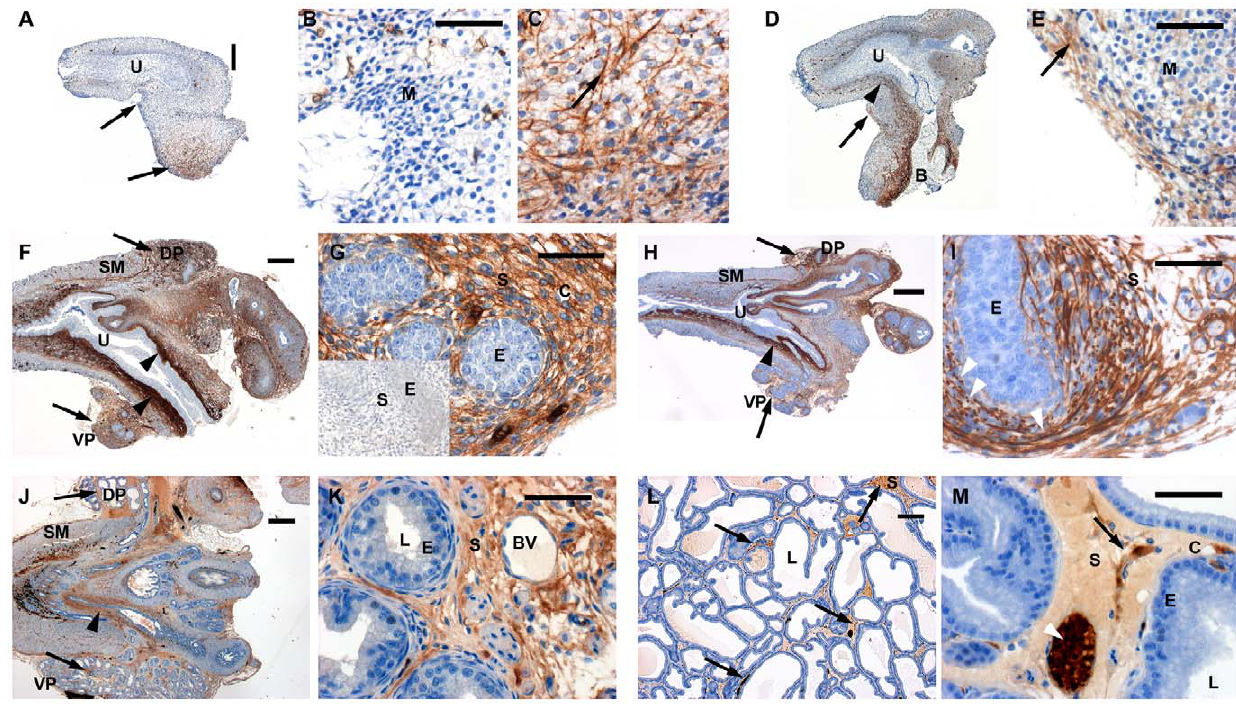
Figure 2. Immunolocalisation of Decorin in the developing rat prostate. Developmental stages of E17.5 (A-C), E19.5 (D, E), P0.5 (F, G), P6.5 (H, I), P28 (J, K) and young adult (L, M) were investigated. At developmental stages E17.5, E19.5 the magnifications show the areas of prospective VP, while at P0.5 and P6.5 the VP or DP are shown. Decorin was absent in epithelium and the smooth muscle compartment but present in the mesenchyme/stroma. The expression was especially strong in mesenchyme adjacent to urethral and prostatic epithelium, as indicated by black arrowheads and arrows. Notably, Decorin appeared to co-localise with structural fibres in the extracellular matrix, indicated by white arrowheads in I and M. Legend: B bladder, BV blood vessel, C capillary, DP dorsal prostate, E epithelium, M mesenchyme, L lumen of prostatic ducts, S stroma, SM smooth muscle, U urethra, VP ventral prostate. Scale bars: 200 m m in A, D, F, H and L, 400 m m in J, and 50 m m in all others. Please note that panel H has been size adjusted – including the scale bar - and is not at the same magnification as panels A, D and